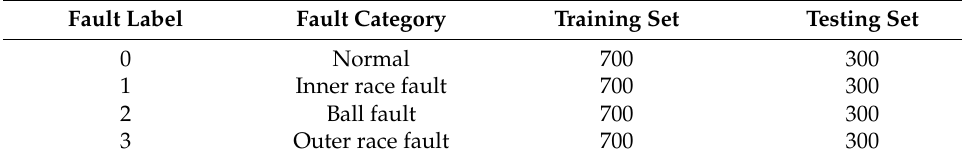
Table 2. The experimental dataset of IMS.